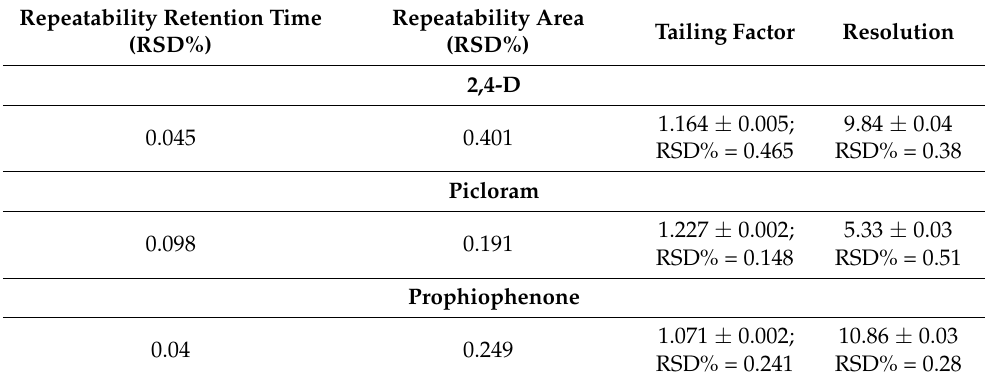
Table 1. System suitability